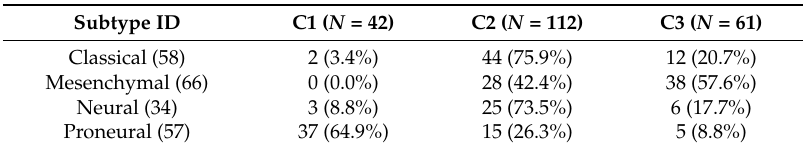
Table 7. The overlaps of the identified subtype clusters with the TCGA clinical subtypes in GBM cancer datasets.